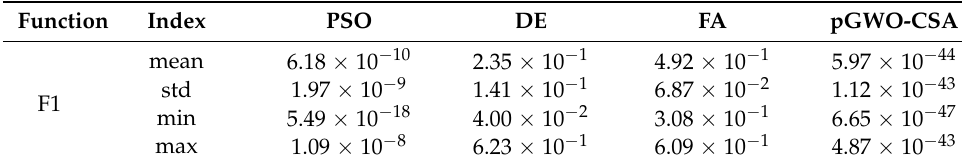
Figure 5. Convergence curve of test function F1. Table 3. The experimental results under 30